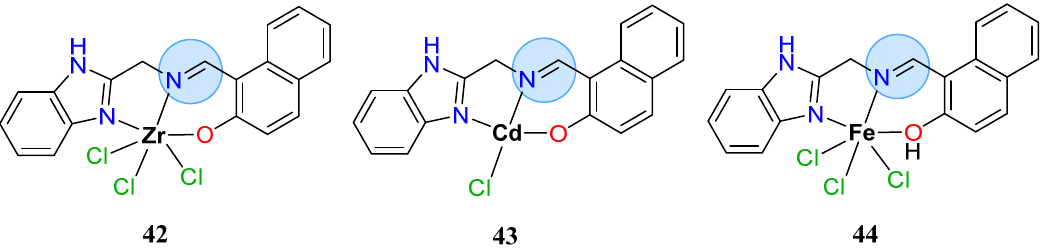
Figure 19. Zr(IV), Cd(II), and Fe(III) complexes with a Schiff base synthetized from 2 ‐ ami ‐ nomethylbenzimidazole and 2 ‐